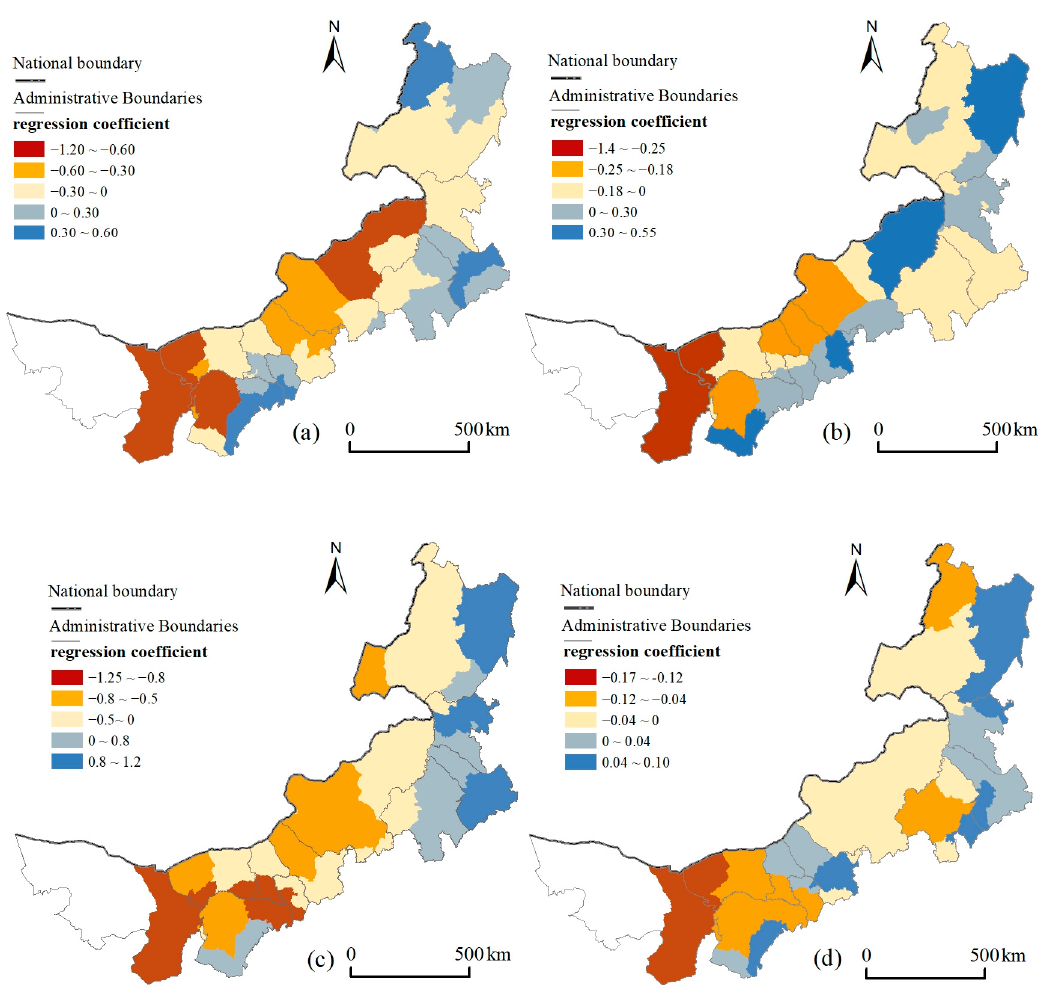
Figure 6. Distribution of the regression coefficient of SPEI with ( a ) MAT, ( b ) MP, ( c ) Elevation, and ( d ) DTR.